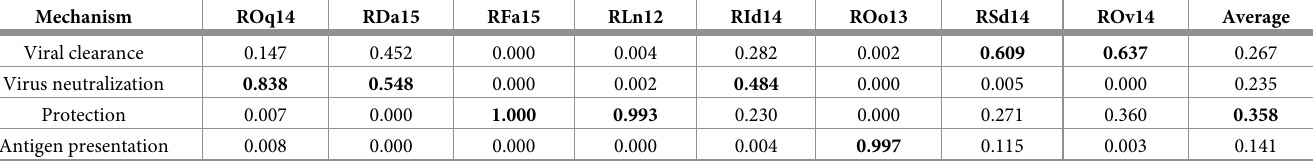
Table 2. The AIC weight � for increased viral clearance, viral neutralization, protection, and improved antigen presentation mechanisms for the baseline source model. Mechanism